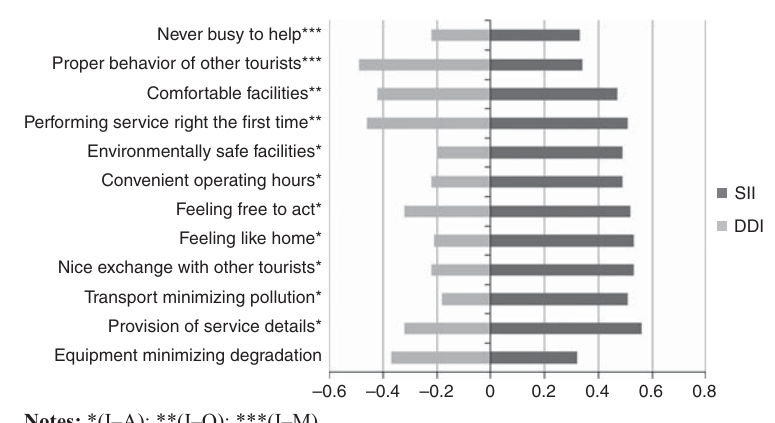
Figure 6. CS Coefficients of one- dimensional attributes